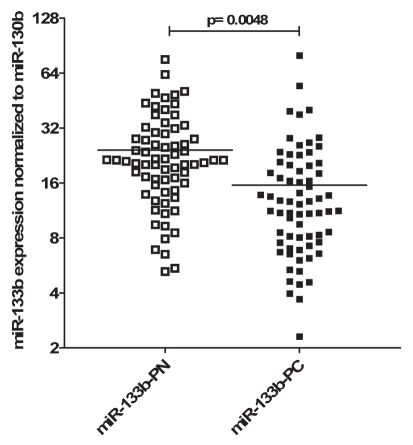
Samples from human prostate cancer patients have decreased expression of miR-133b.Scatter dot-plot of miR-133b expression. RT-qPCR was used to determine miR-133b expression in 69 primary prostate cancer tissues and corresponding normal adjacent tissue. Lines represent mean expression values. MiR-133b was normalized to miR-130b, since it shows a very stable expression pattern both in tumors and normal tissue.